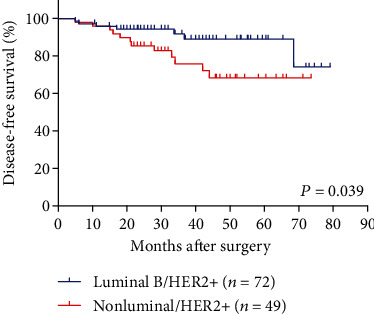
DFS curves of luminal B/HER2+ and nonluminal B/HER2+ patients in non-pCR patients without trastuzumab use.